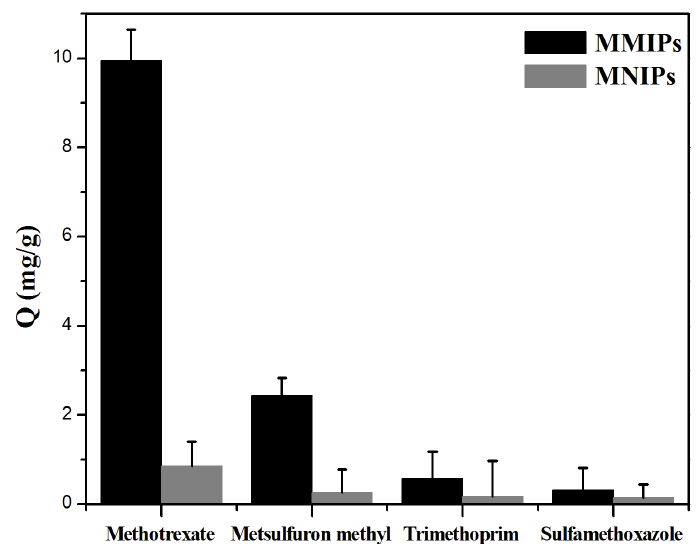
Figure 3. Adsorption performance of MMIPs and MNIPs on MTX and its structural analogues (0.25 mg mL −1